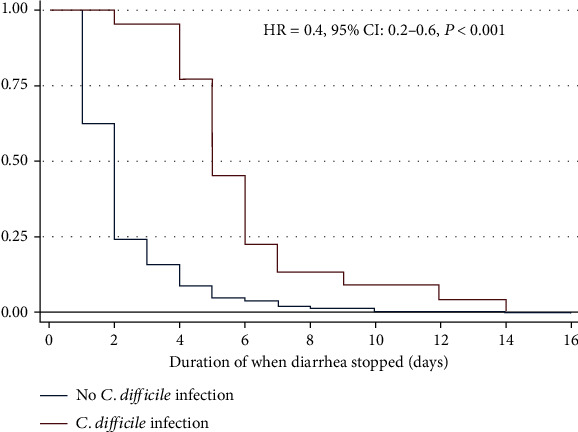
Kaplan-Meier curve showing the rate of when diarrhea stopped between CDI positive and CDI negative.